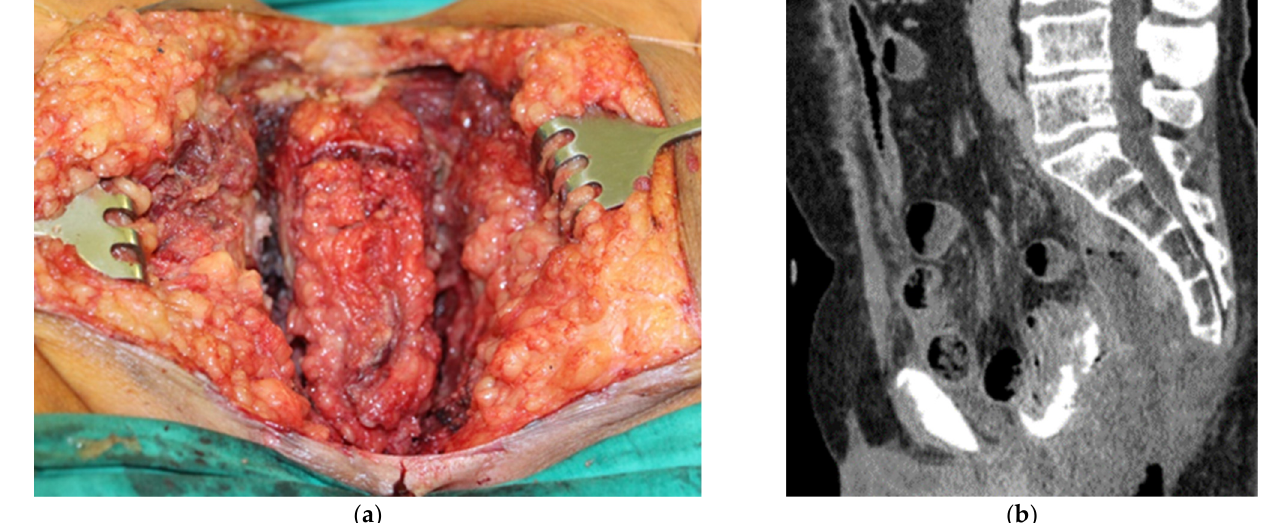
Figure 6. ( а ) The borders of the sacrum resection are outlined in the patient in “jackknife” position; ( b ) Postoperative CT scan.